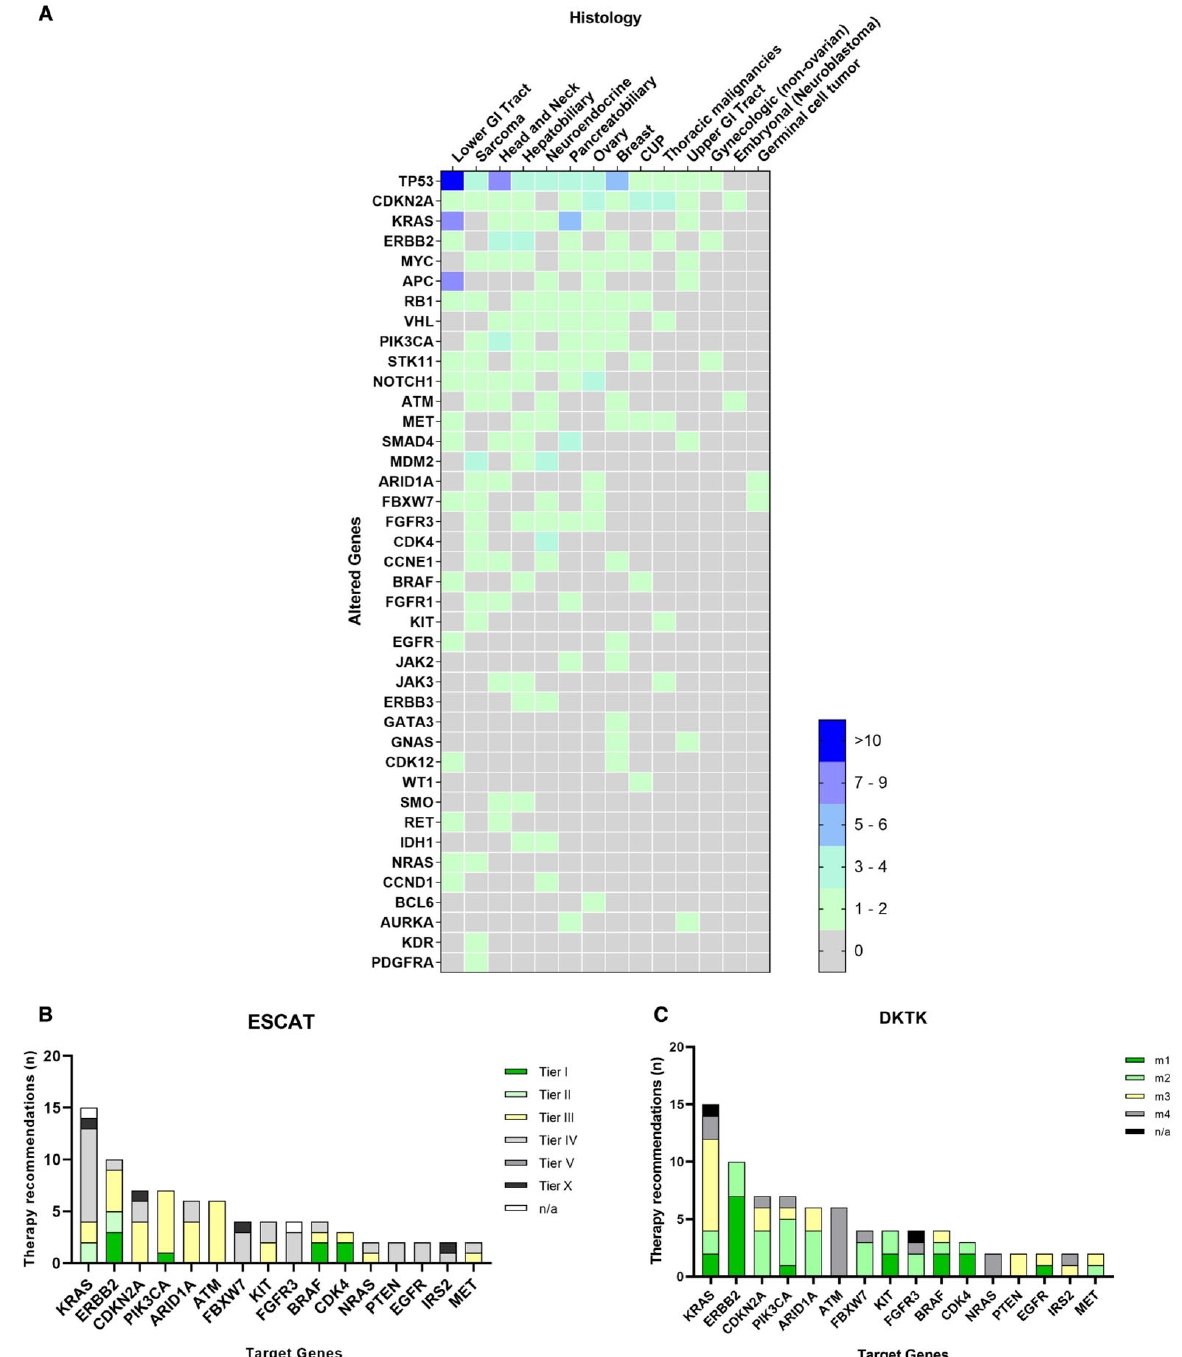
Figure 3 . SSVs and CNAs in n = 104 tumors identified by combined focused sequencing assays. ( A ) Figure 3. SSVs and CNAs in n = 104 tumors identified by combined focused sequencing